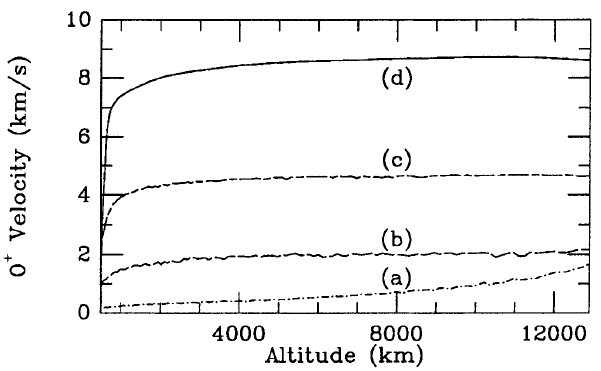
Fig. 16. Profiles of the O (cid:135) outflow velocity. The labels correspond to the cases listed in